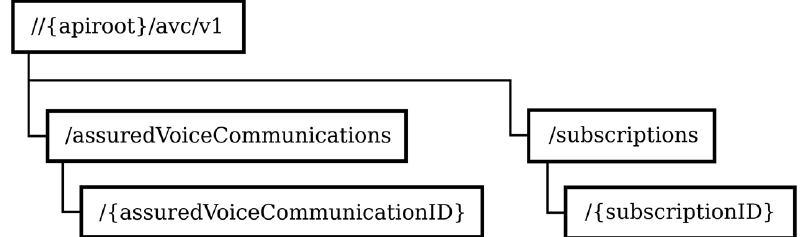
Figure 7. Structure of resource URIs related to assured voice communications.